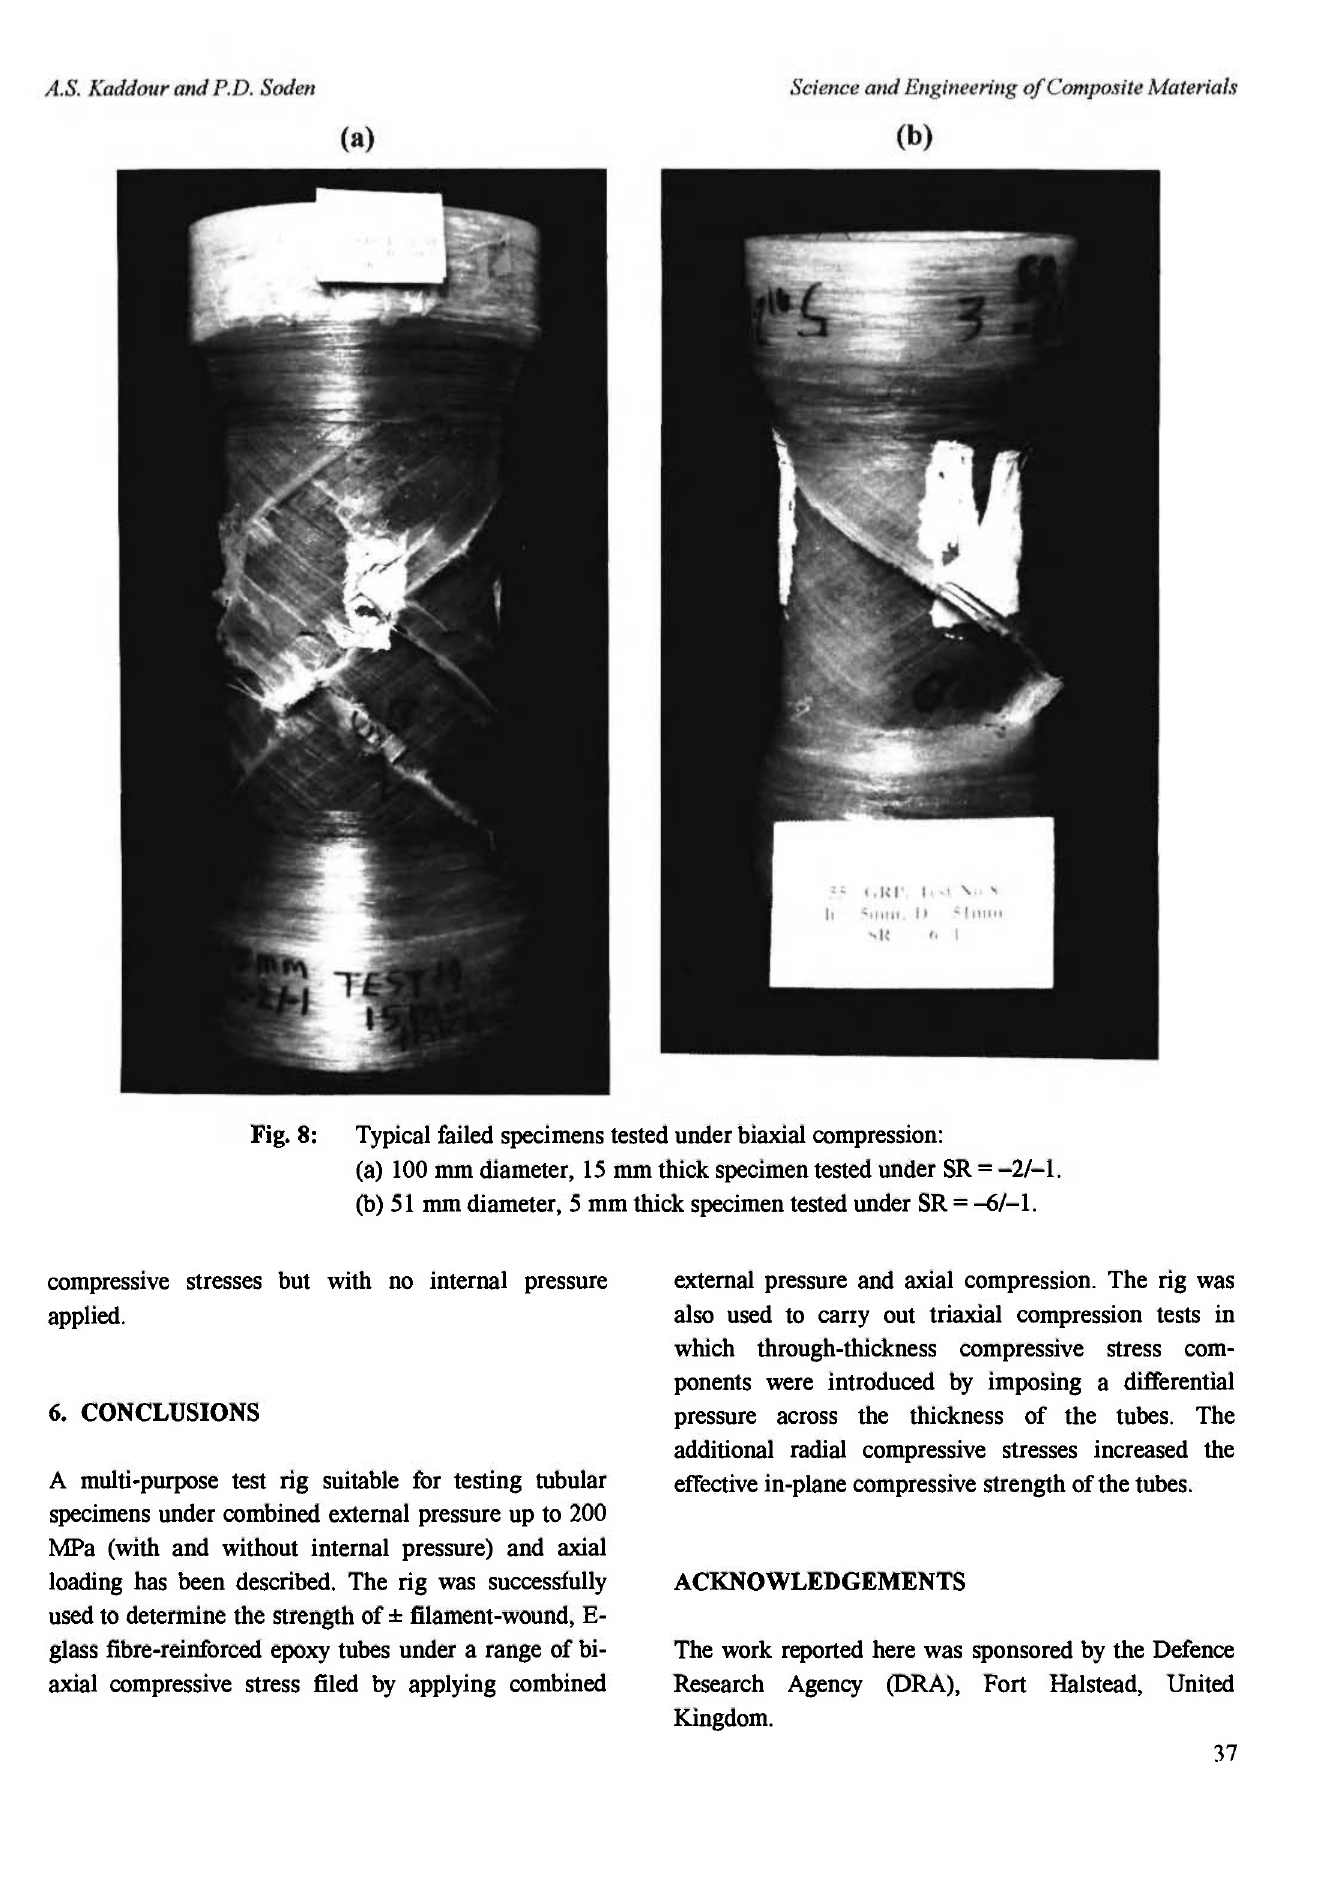
Fig. 8: Typical failed specimens tested under biaxial compression: (a) 100 mm diameter, 15 mm thick specimen tested under SR = -2/-1. (b) 51 mm diameter, 5 mm thick specimen tested under SR =